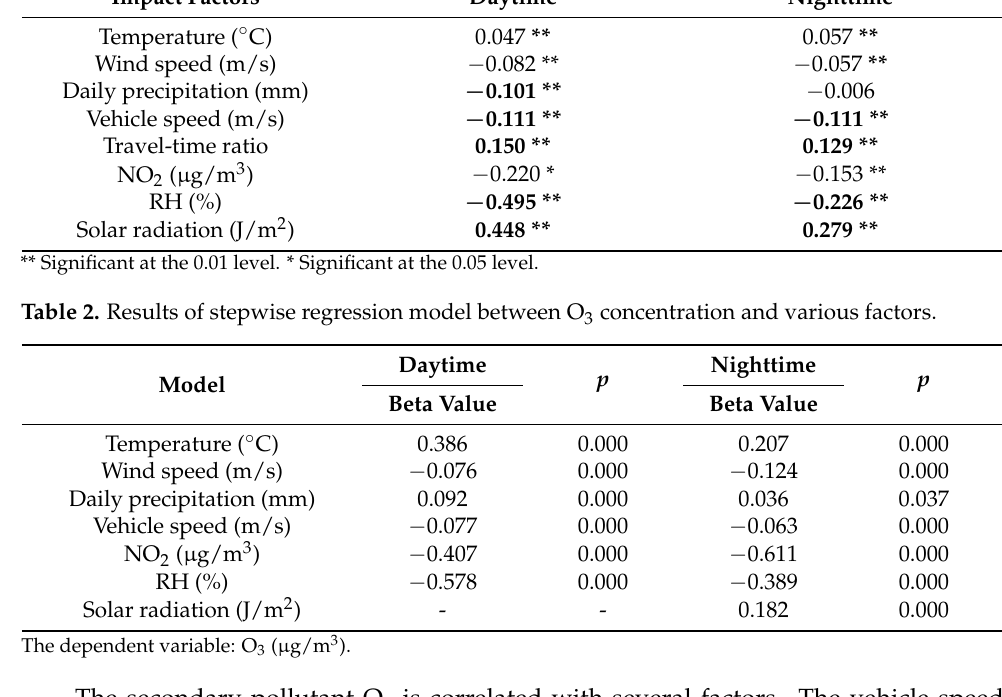
Table 1. Pearson’s correlation coefficients between O 3 concentration and various factors. Impact Factors Daytime Nighttime Temperature ( ◦ C) 0.047 ** 0.057 ** Wind speed (m/s) − 0.082 ** − 0.057 ** Daily precipitation (mm) − 0.101 **